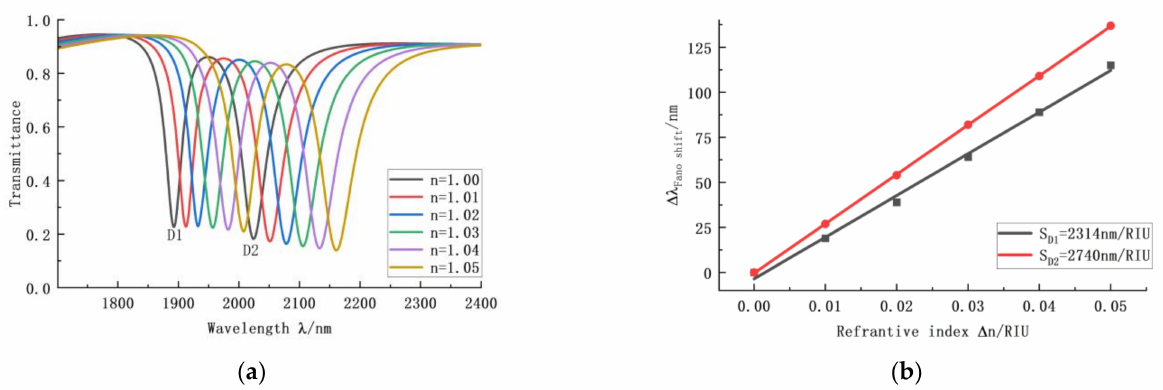
Figure 7. ( a ) Transmission curve spectrum for a change in refractive index n. ( b ) Fitted sensitivity curve of the refractive index sensor.